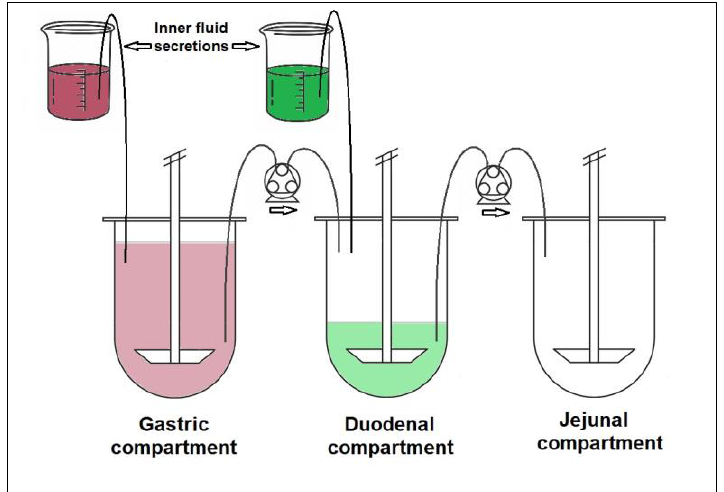
Figure 1. Gastrointestinal Simulator [16].